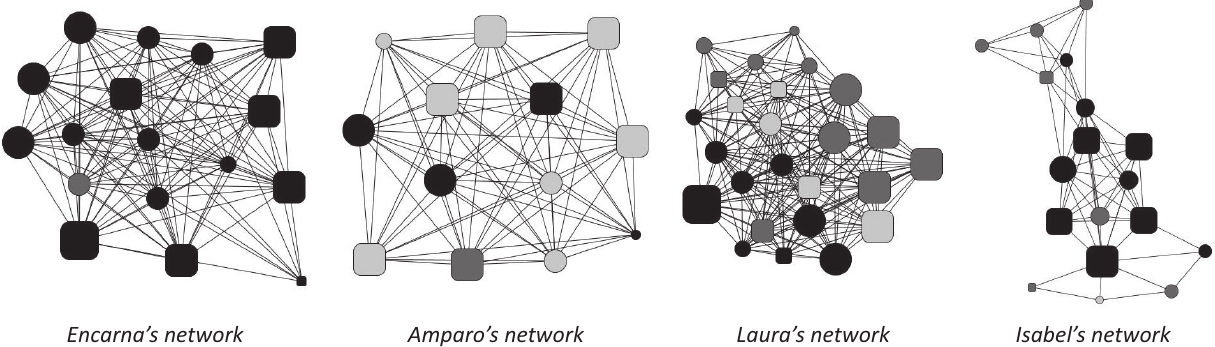
Figure 5. Comparison of the four personal networks. Notes: Node size indicates relational role—size 1 (biggest; closest family: parents, brothers/sisters, and sons/daughters), size 2 (in‐laws), size 3 (friends, neighbours), size 4 (distant rela‐ tives), size 5 (smallest; social worker, “others”); node shape indicates gender—circle (female), rounded‐square (male); node colour indicates proximity: black (“very close”), dark grey (“close”), light grey (“not very close”), white (“not close at all”); edge shape: line (“know each other”), square with rounded angles (“maybe know each other”), no edge (“don’t know each